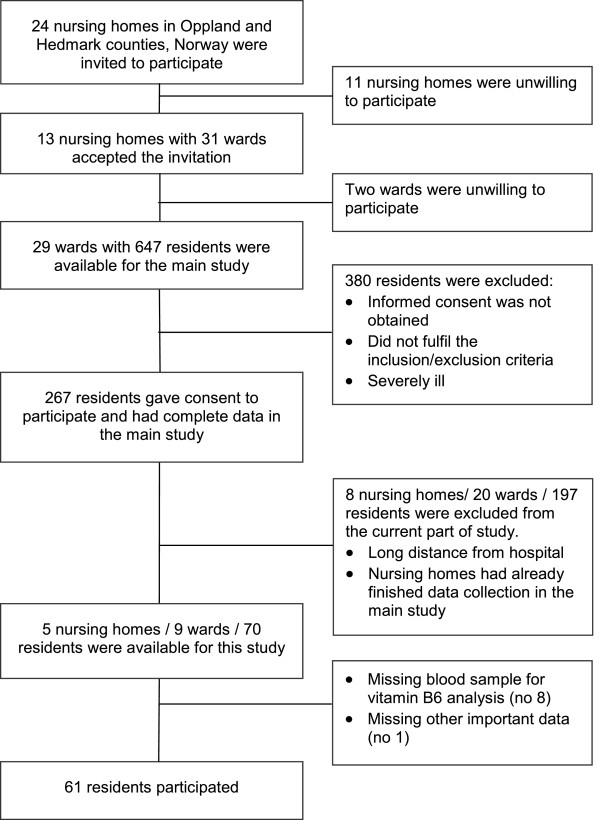
Flow chart of the participants in the study.